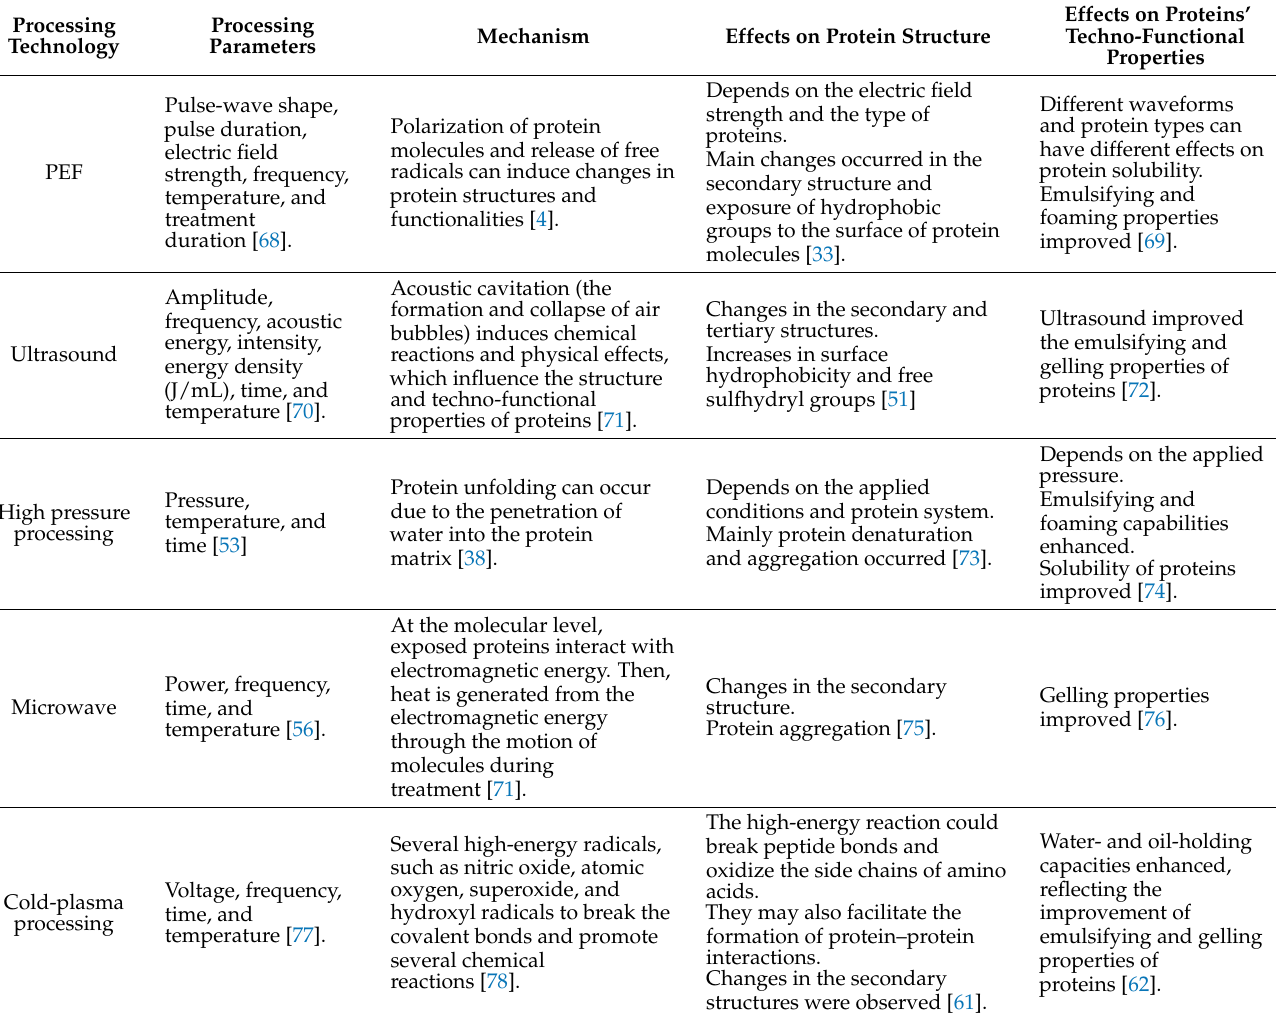
Table 1. Brief comparison of different emerging processing techniques and their effects on protein structure and techno-functional